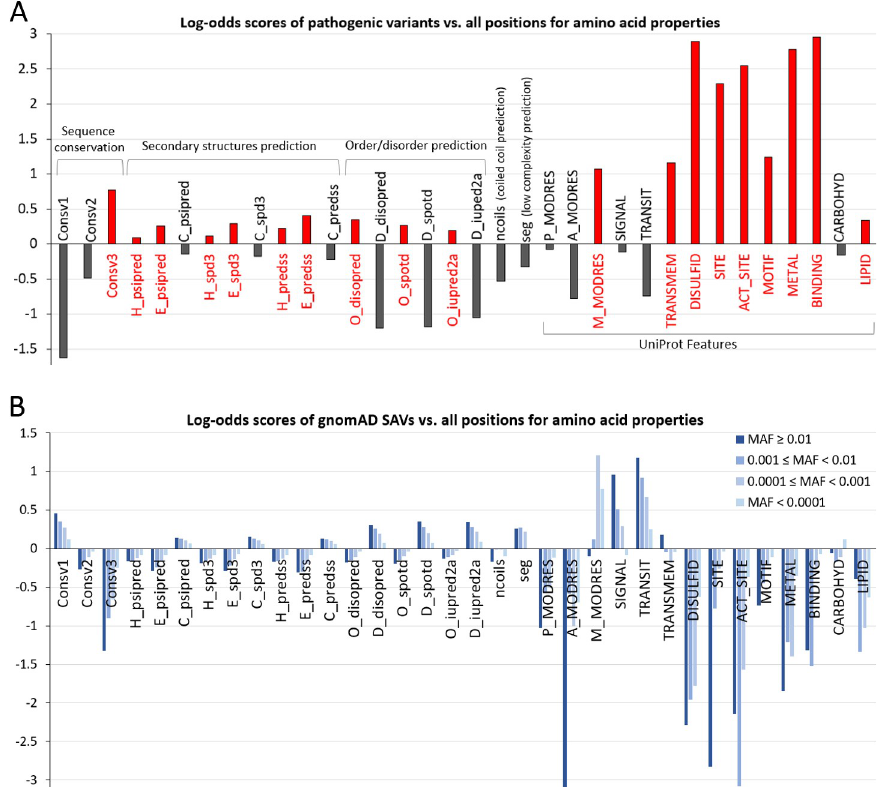
Fig 2. Enrichment of SAVs among sequence, structure and functional properties. A) Enrichment/depletion of properties in pathogenic SAVs compared to all amino acid positions (y-axis shows log2 based log-odds scores). Notations: Consv1 –positions with low conservation scores (between 0 and 0.3), Consv2 –positions with medium conservation scores (between 0.3 and 0.6), Consv3 –positions with high conservation scores (larger than 0.6). H_psipred, E_psipred, C_psipred are secondary structure predictions of α -helix, β -strand, and coil by PSIPRED. The same notation is used for secondary structure prediction programs SPIDER (H_spd3, E_spd3, C_spd3) and PREDSS (H_predss, E_predss, C_predss). O_disopred and D_disopred correspond to ordered and disordered regions predicted by DISOPRED respectively, and the same notation is used for disorder prediction programs SPOT-DISORDER (O_spotd and D_spotd) and IUPRED2A (O_iupred2a and D_iupred2a). The notations ncoil and seg are predicted coiled coil region and low complexity region, respectively. P_MODRES, A_MODRES, and M_MODRES are positions annotated as being modified with phosphorylation, acetylation, and methylation in UniProt, respectively. SIGNAL, TRANSIT, and TRANSMEM are positions annotated as signal peptide, transit peptide, and transmembrane segment in UniProt. DISULFID, SITE, ACT_SITE, MOTIF, METAL, BINDING, CARBOHYD and LIPID are positions annotated in these key words in UniProt Feature fields (see Materials and methods for their definitions). B) Enrichment/depletion of amino acid properties in gnomAD SAVs with different MAF ranges (from light blue to dark blue: MAF < 0.0001, 0.0001 � MAF < 0.001, 0.001 � MAF < 0.01, 0.01 � MAF) compared to all amino acid